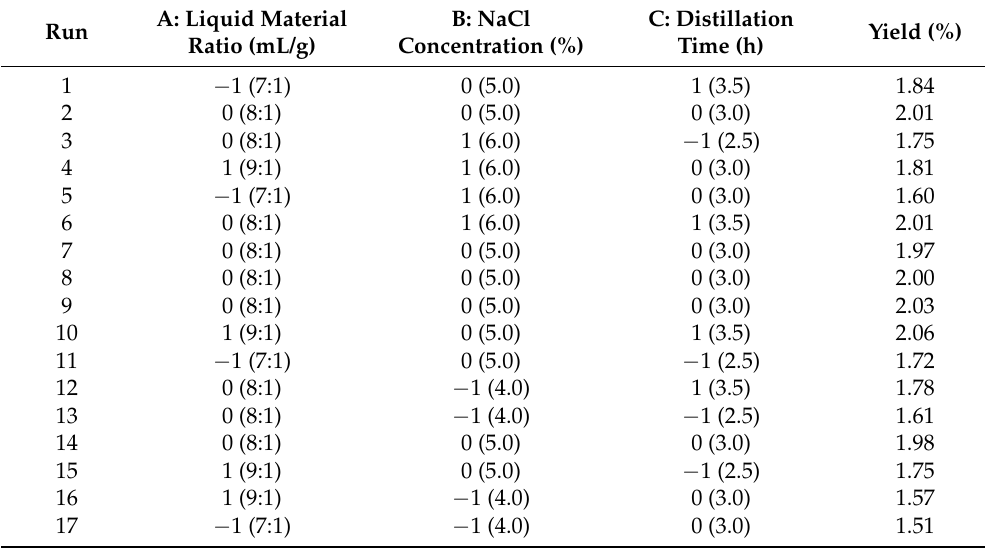
Table 1. The Box–Behnken experimental design and